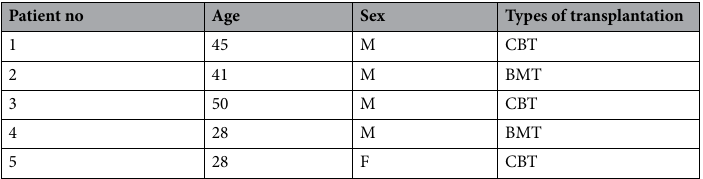
Table 1. Information of patients included in this study. Four male patients (M) and one female patients (F) were recruited in this study. Among these patients, three have undergone cord blood transplantation (CBT) and two have undergone bone marrow transplantation